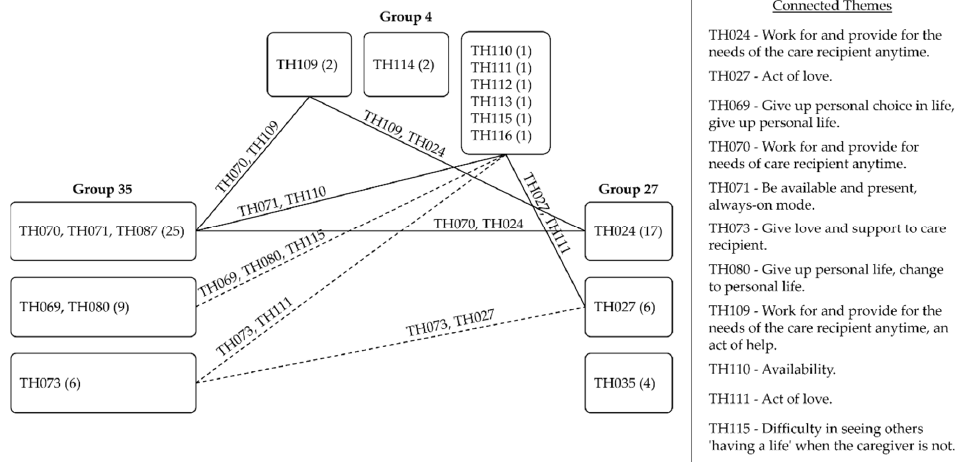
Figure 3. Network of themes in reflection.